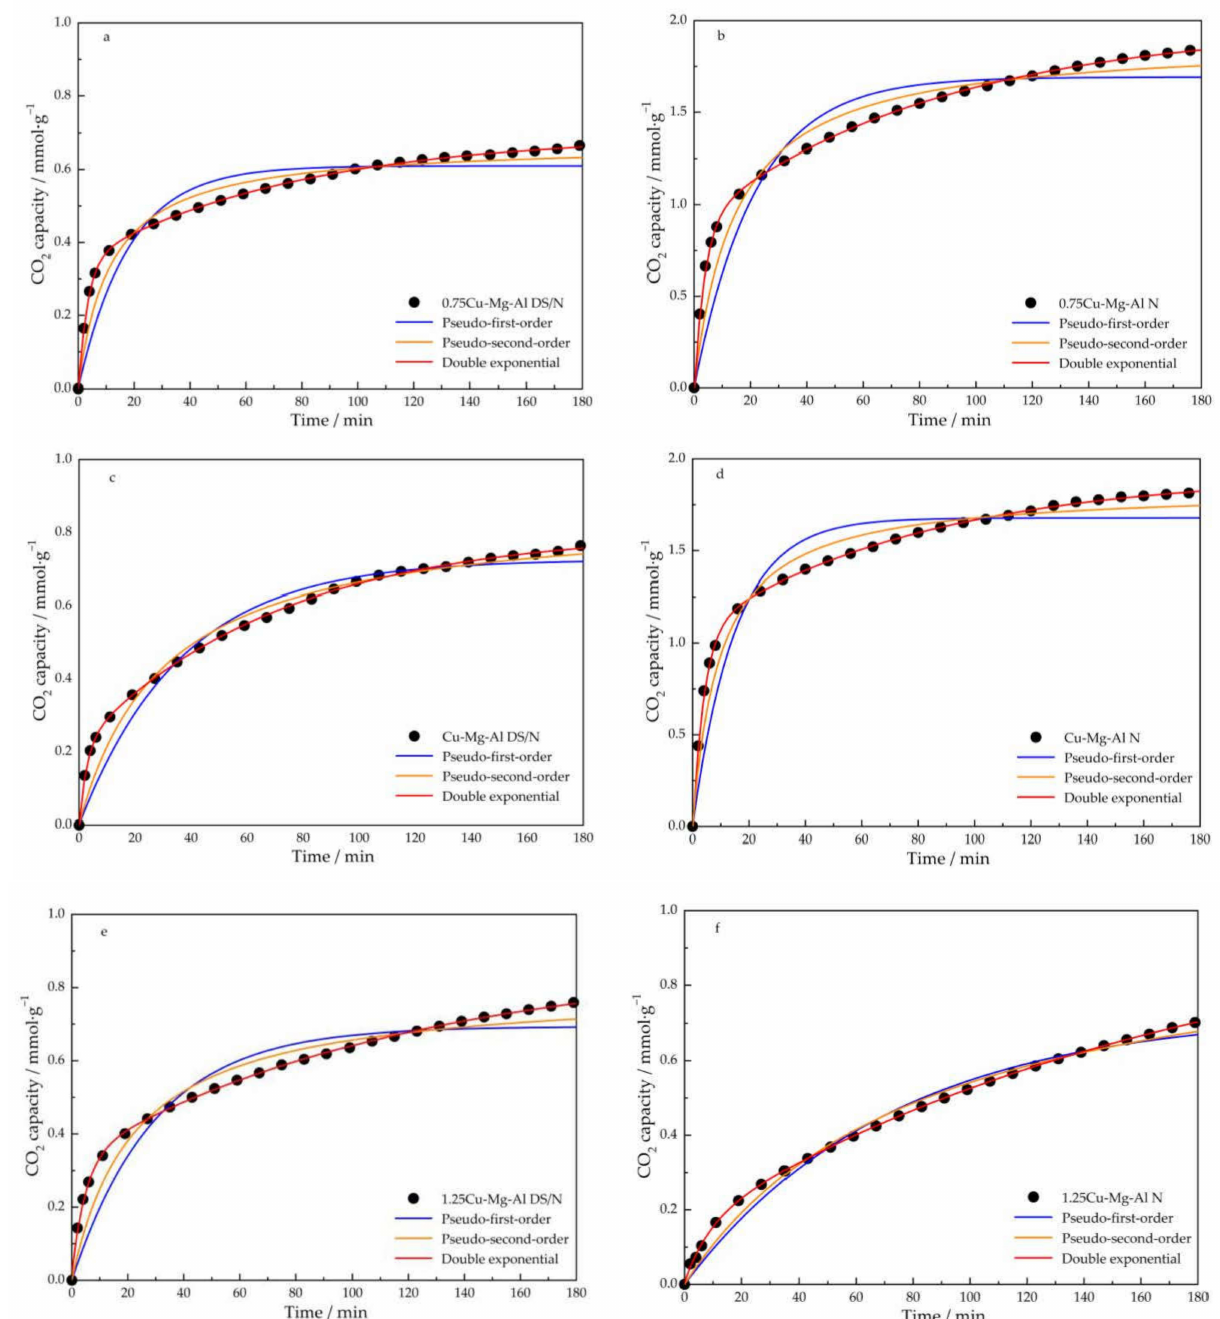
Figure 10. Comparison of different kinetic models with the experimental data of the CO 2 adsorption on 0.75Cu-Mg-Al DS/N ( a ), 0.75Cu-Mg-Al N ( b ), Cu-Mg-Al DS/N ( c ), Cu-Mg-Al N ( d ), 1.25Cu-Mg- Al DS/N ( e ), and 1.25Cu-Mg-Al N ( f